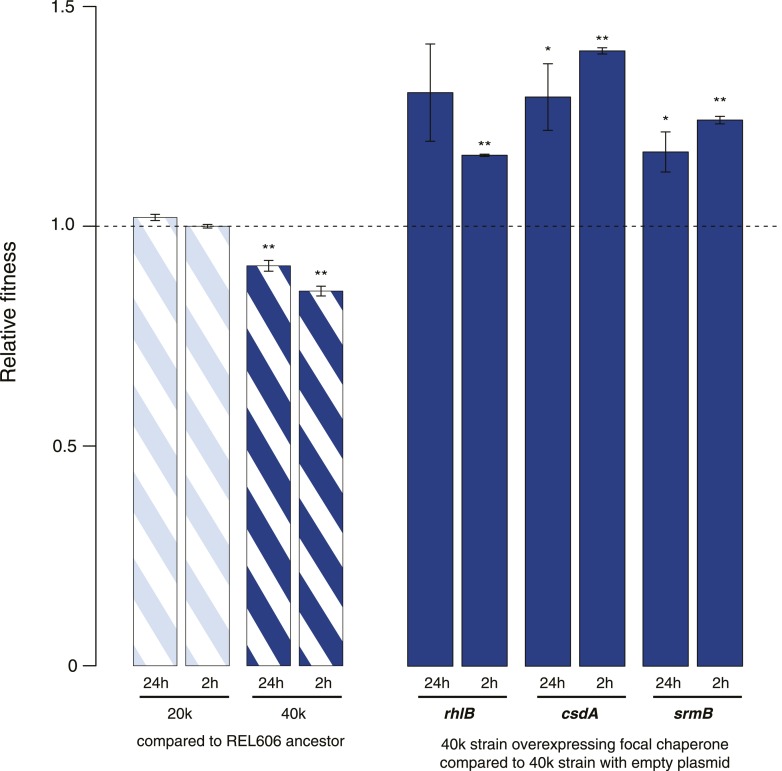
Relative fitness in competition experiments terminated in mid-exponential phase (REL606).